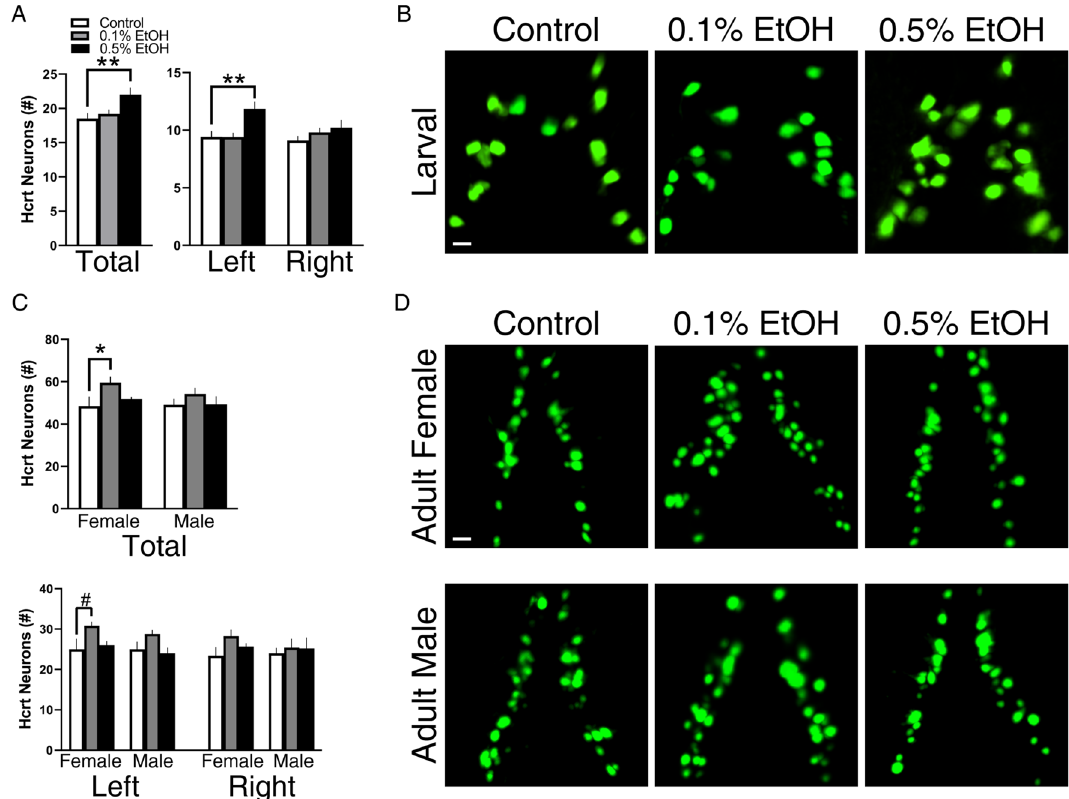
Figure 3. Effects of embryonic EtOH from 22 to 24 hpf on Hcrt neuron number in the AH measured in 6 dpf larval zebrafish using live-imaging and in adult zebrafish using iDISCO clearing. ( A ) EtOH at 0.5% (n = 14) but not 0.1% (n = 20) increases the total number of Hcrt neurons and the number of Hcrt neurons on the left but not right side in 6 dpf larval zebrafish compared to control (n = 19). ( B ) These effects in larval zebrafish are illustrated in representative confocal images of the AH. They show that 0.5% but not 0.1% increases the total and left side number of GFP-positive Hcrt neurons (green) in 6 dpf larval zebrafish compared to control. ( C ) EtOH in adult females at 0.1% (n = 5) but not 0.5% (n = 6) increases the total number of Hcrt neurons and increases the number of Hcrt neurons on the left but not right side of the AH compared to control (n = 4), with no changes occurring in males at 0.1% (n = 5) or 0.5% (n = 5) relative to control (n = 5). ( D ) These effects in adults are illustrated in representative confocal images showing the total population of Hcrt neurons in the AH. They show that 0.1% but not 0.5% increases the total number of Hcrt neurons in females (middle row) but not males (bottom row) and increases the number of Hcrt neurons on the left but not right side only in adult females compared to control. Results are shown as means ± standard errors. *p < 0.05, **p < 0.01. # p <